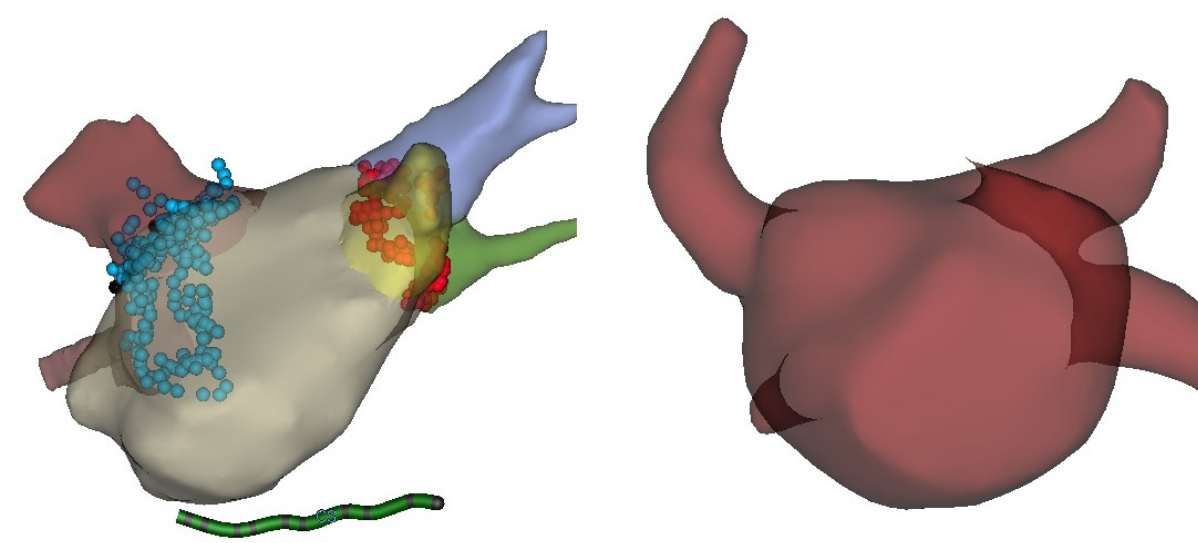
Fig. 2. On the right, there is a 3D image of the left atrium obtained from CT scan. On the left, there is shown an electroanatomical map of the left atrium based on the image obtained from CT (the red and blue points mark location of RF